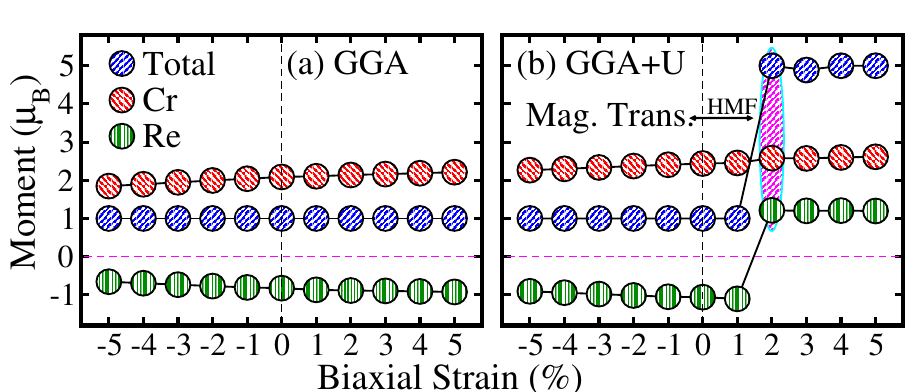
Figure 6. Calculated GGA+ U spin-polarized orbital resolved partial density of states (PDOS) of Cr/Re 3/5 d in Sr 2 CrReO 6 for ( a , a ′ ) biaxial + 2% and hydrostatics ( b , b ′ ) + 2% and ( c , c ′ ) + 3% tensile strains.